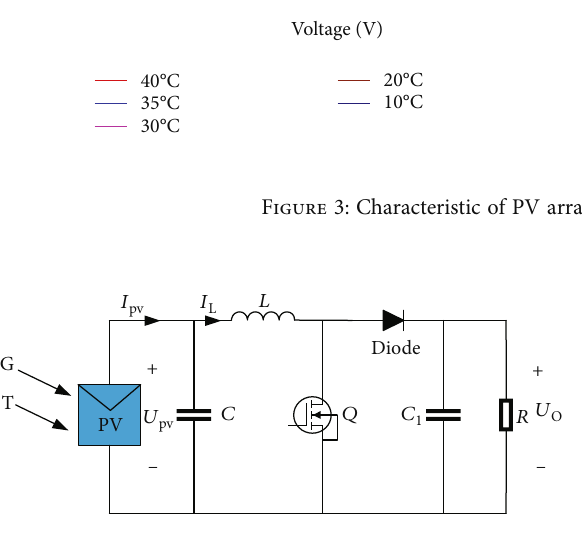
Figure 4: Topology of PV Boost